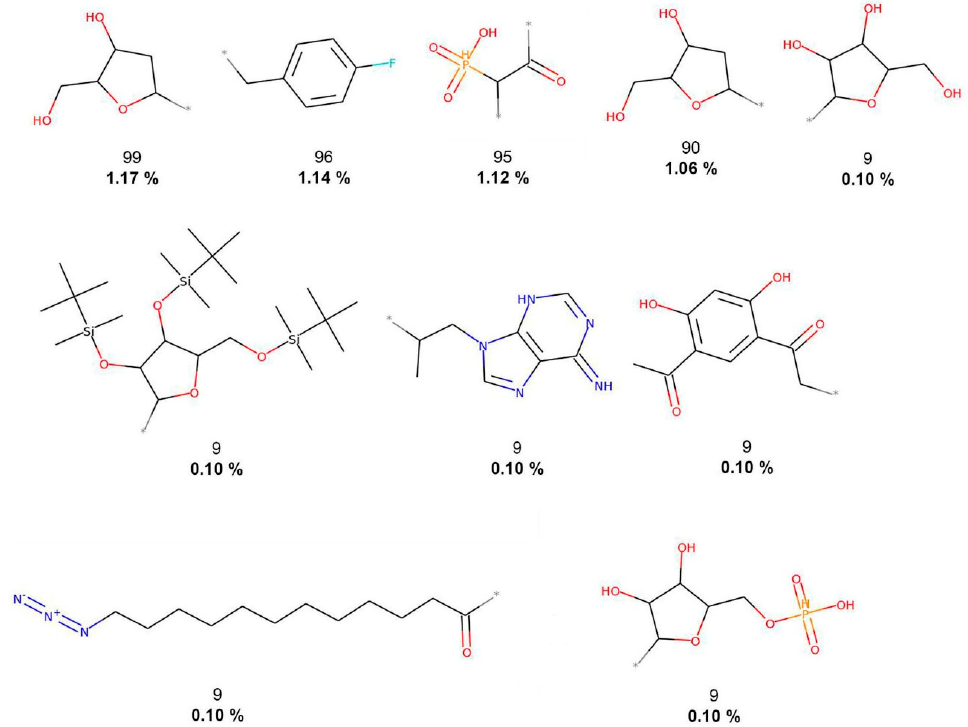
Figure 5. The 10 most frequent and unique CAS fragments. Frequency (regular bond) and proportion (bold font) are listed below the chemical structures.